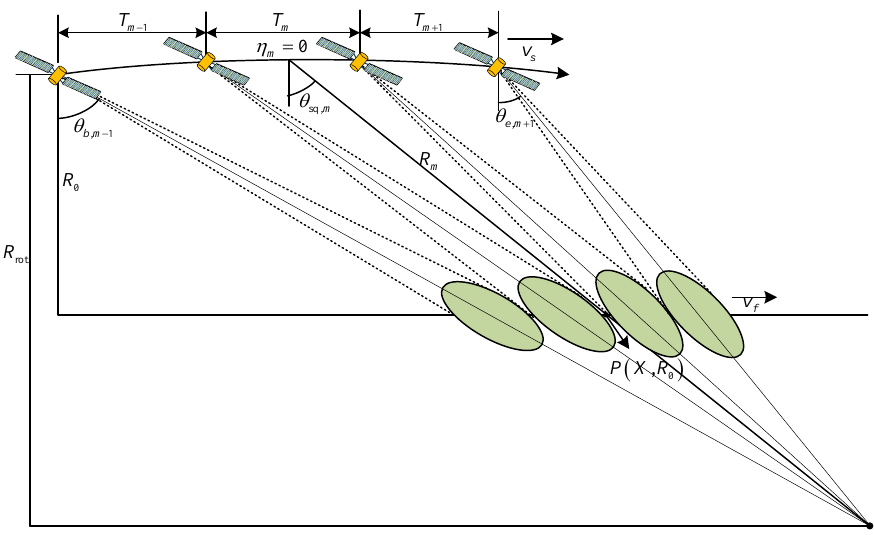
Figure 7. The imaging geometry of spaceborne squint sliding-spotlight SAR with BV-PRF.